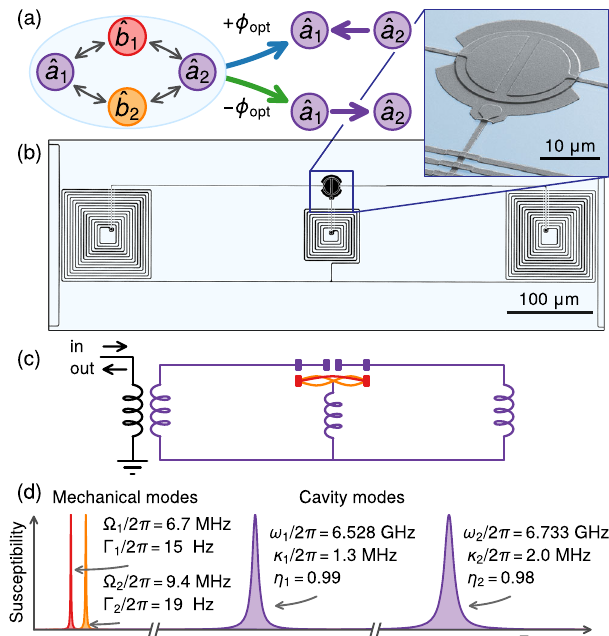
FIG. 1. Concept and experimental realization. (a) Mode-cou- pling diagrams for the optomechanical isolator. Optomechanical interactions (double-sided arrows) between two cavity modes ( ˆ a 1 ˆ ˆ b 1 and b 2 ) induce directional and ˆ a 2 ) and two mechanical modes ( scattering between the two cavities when the parametric loop phase is equal to its optimal values (cid:3) ϕ . (b) Microscope images opt of the device. A microfabricated vacuum-gap capacitor (inset) resonates with spiral inductors to produce two electromagnetic cavities. (c) Schematic of the optomechanical circuit. Input signals from microwave generators couple inductively to the device and reflect back through the amplification chain to be measured by a network or spectrum analyzer. (d) Frequency space diagram. Mode susceptibilities are plotted versus fre- quency. Two mechanical modes and two cavity modes are characterized by their resonant frequencies ( Ω and ω ) and k j their linewidths ( Γ and κ ), and the cavities are further charac- k j terized by their coupling efficiencies η j